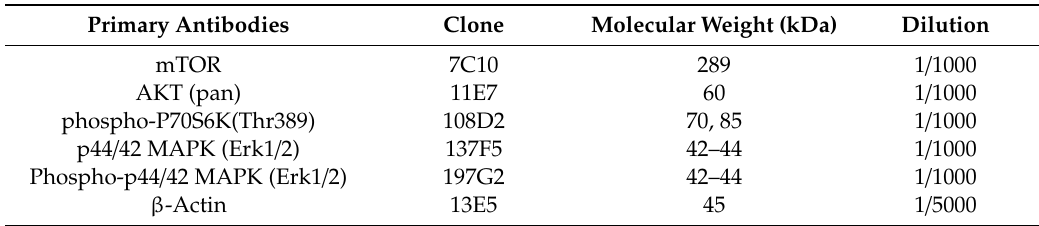
Table 1. Primary antibodies used for Western blot analysis. MAPK: mitogen-activating protein kinase. Primary Antibodies Clone Molecular Weight (kDa) Dilution mTOR 7C10 289 1 / 1000 AKT (pan) 11E7 60 1 / 1000 phospho-P70S6K(Thr389) 108D2 70, 85 1 / 1000 p44 / 42 MAPK (Erk1 / 2) 137F5 42–44 1 / 1000 Phospho-p44 / 42 MAPK (Erk1 / 2) 197G2 42–44